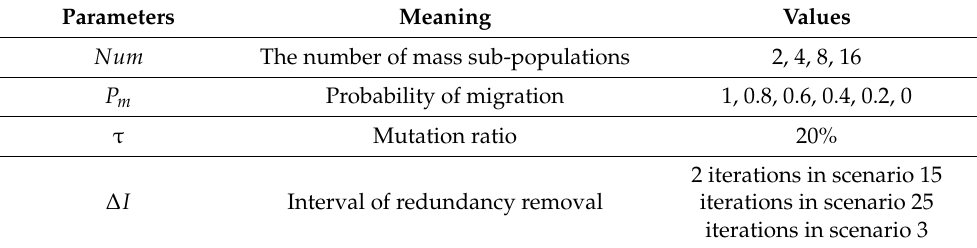
Table 3. Control parameters of